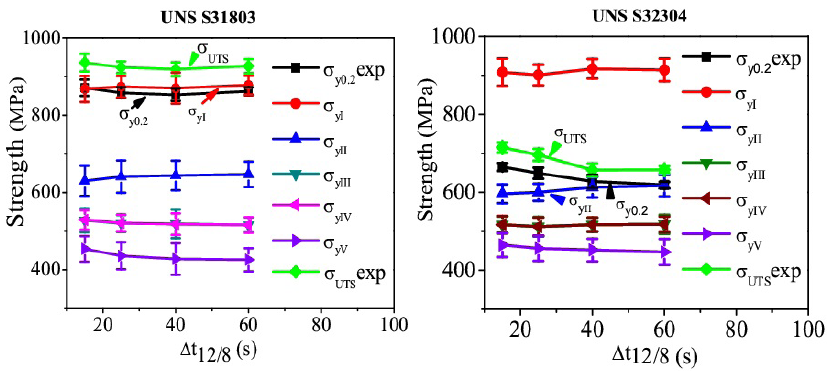
) and yield strength (σ ) values, and the calculated yield strength according to UTS y0.2 , at the HAZs for the tested cooling times in the UNS S31803 and UNS S32304 yI-V